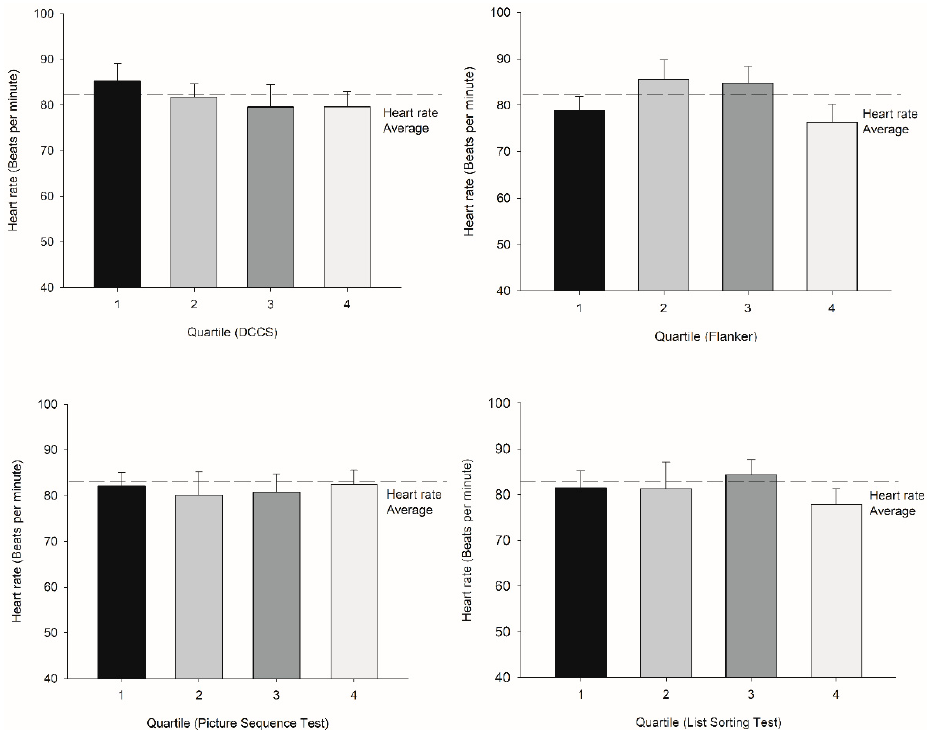
Figure 2. Upper left: Quartile comparisons (determinants: DCCS) in terms of heart rate (error bar: SE) did not demonstrate any significant differences. Upper right: Quartile comparisons (determinants: Flanker) in terms of heart rate did not demonstrate any significant differences. Lower left: Quartile comparisons (determinants: Picture Sequence) in terms of heart rate did not demonstrate any significant differences. Lower right: Quartile comparisons (determinants: List Sorting) in terms of heart rate did not demonstrate any significant differences.